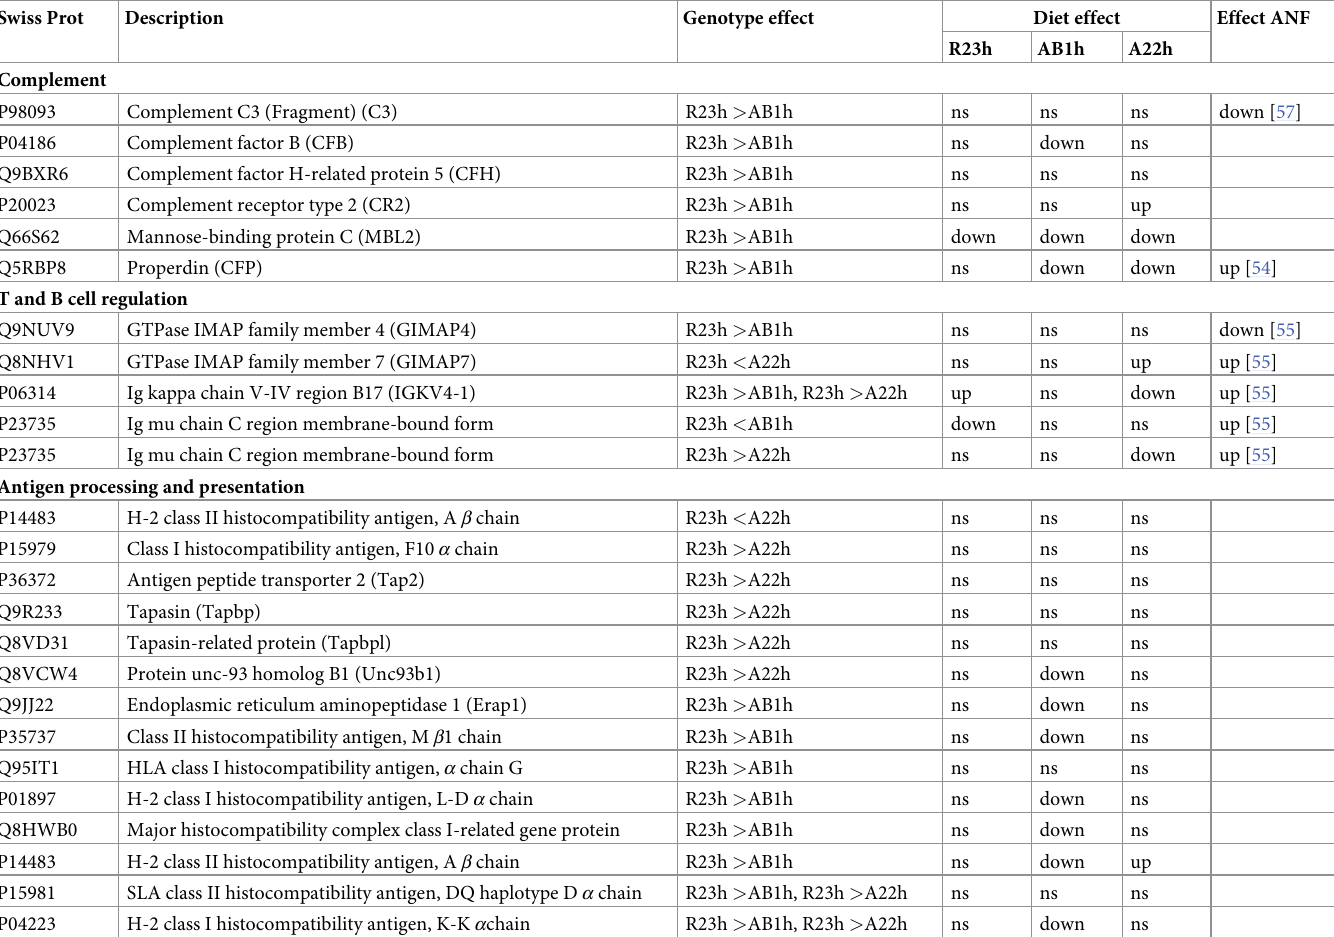
Table 6. Genes differentially expressed between the three isogenic lines related to immunity. Swiss